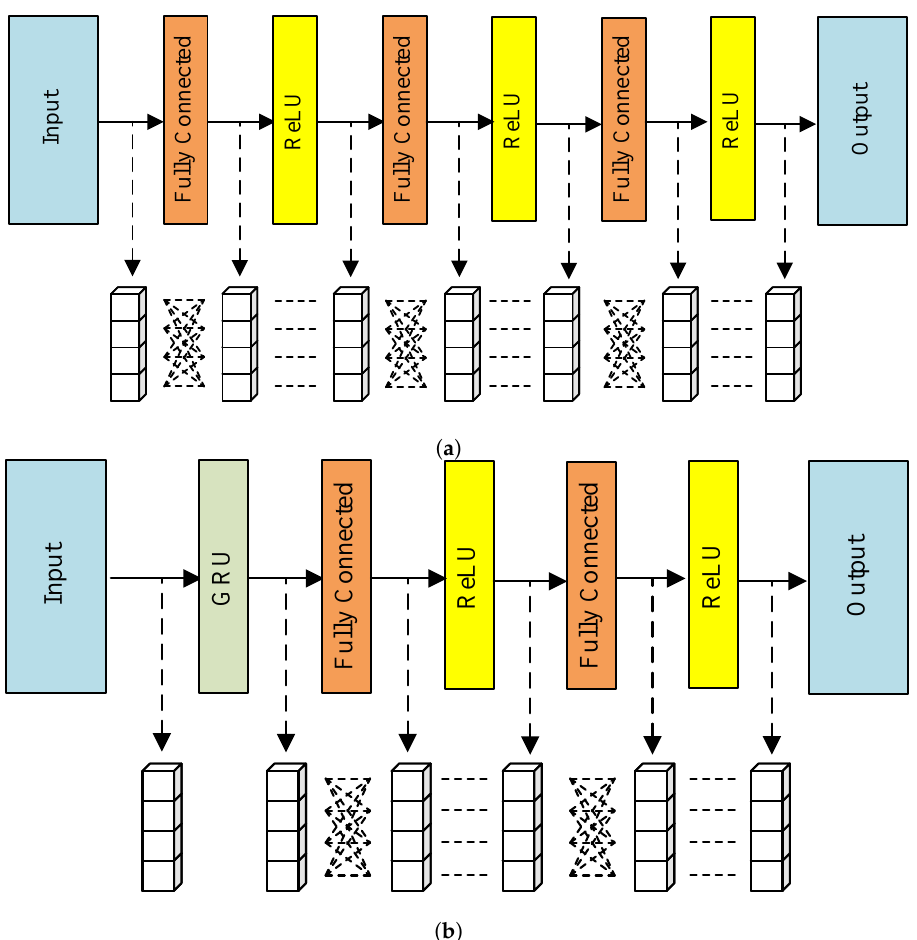
Figure 3. Illustration of the adopted network structures. ( a ) Illustration of the adopted DQN structure. ( b ) Illustration of the adopted DRQN